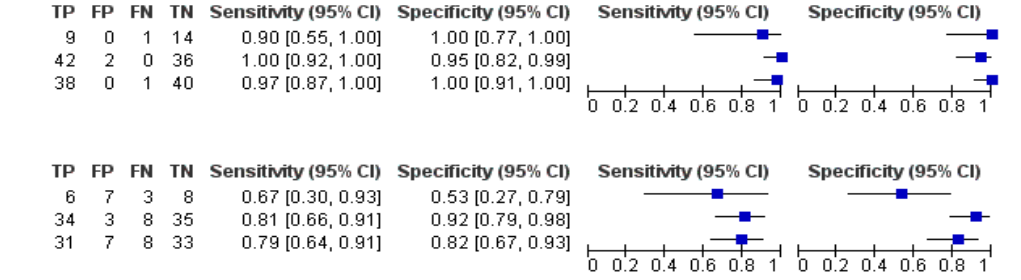
Figure 5. Forest plots demonstrating the sensitivity ( left ) and specificity ( right ) of PO and CT [7,11,29].